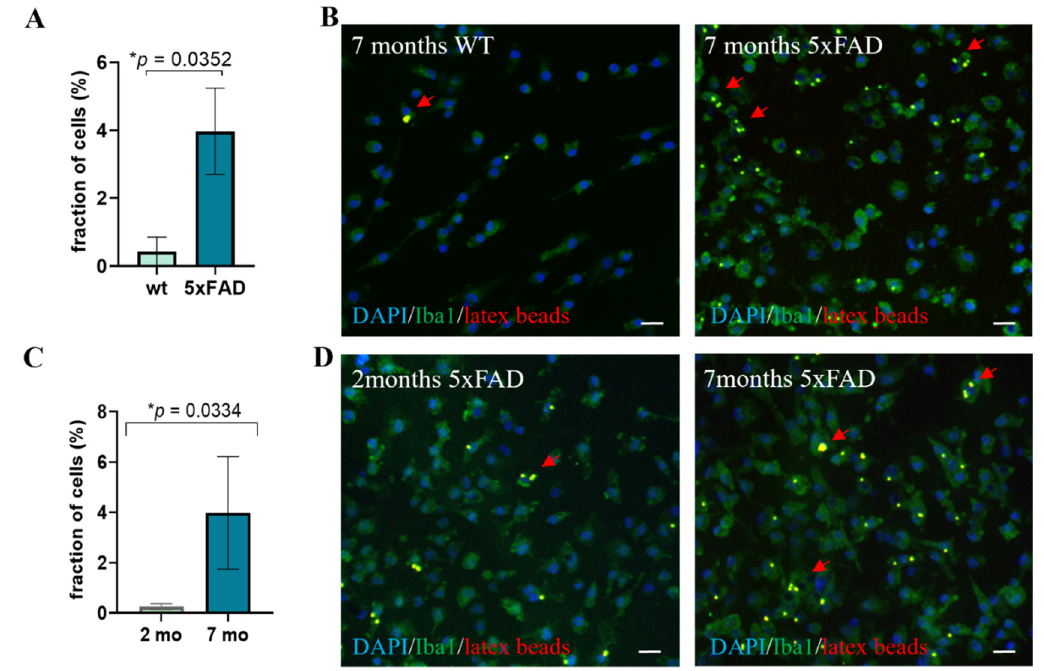
Figure 1. Characterization of latex beads uptake by microglia. ( A ) A higher fraction of microglia from 7-month-old 5xFAD mice exhibit high phagocytic activity ( ≥ 3) latex beads, as compared to microglia from 7-month-old wild type (WT) mice. Student t -test * p = 0.0352. ( B ) Representative images of latex beads’ uptake by microglia from 7-month-old WT and 5xFAD mice. ( C ) A higher fraction of microglia from 7-month-old 5xFAD mice exhibit high phagocytic activity of latex beads, as compared to 2-month-old 5xFAD mice. Student t -test * p = 0.0334. ( D ) Representative images of latex beads’ uptake by microglia from 2- and 7-month-old 5xFAD mice. Red arrows point at cells with ≥ 3 latex beads. Blue = DAPI, green = Iba1, red = latex beads, scale = 20 μ M.